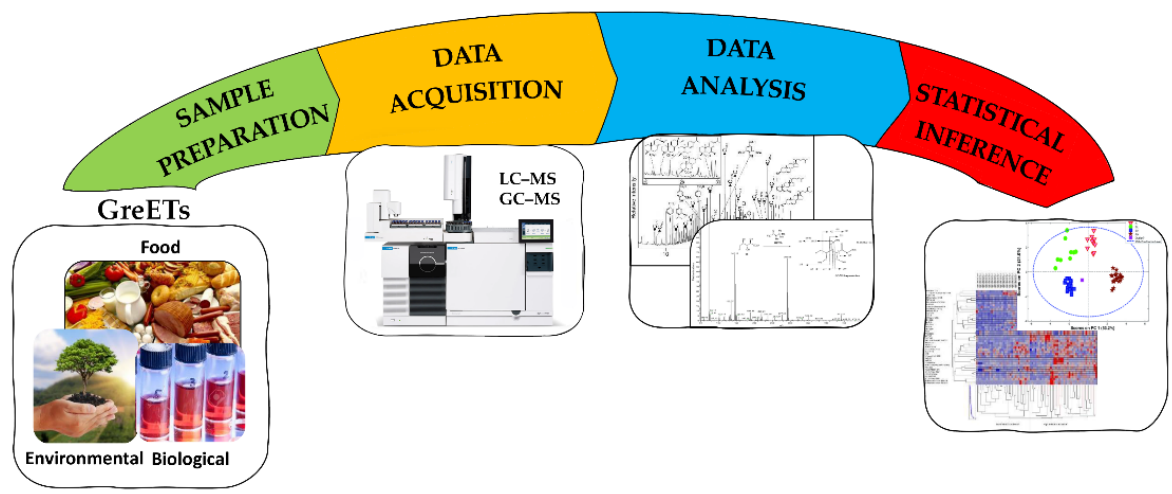
Figure 6. Different steps involved in sample preparation. GreETs: green extraction techniques.